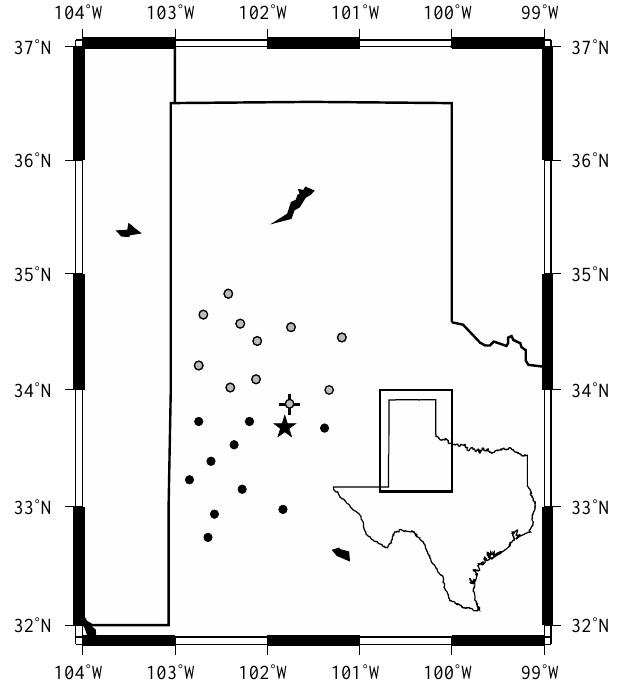
Figure 1. Locations of the 21 West Texas Mesonet (WTM) weather stations providing air and soil temperature data during 2005–2017. Gray (black) locations mark the 11 (10) northernmost (southernmost) stations. Crossed gray token marks the location of the Abernathy WTM station. Star marks the location of the Texas A & M Lubbock AgriLife research location.